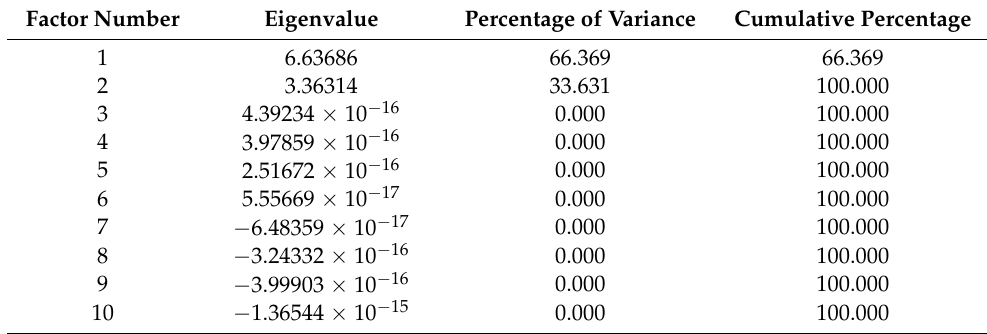
Table 11. Factor